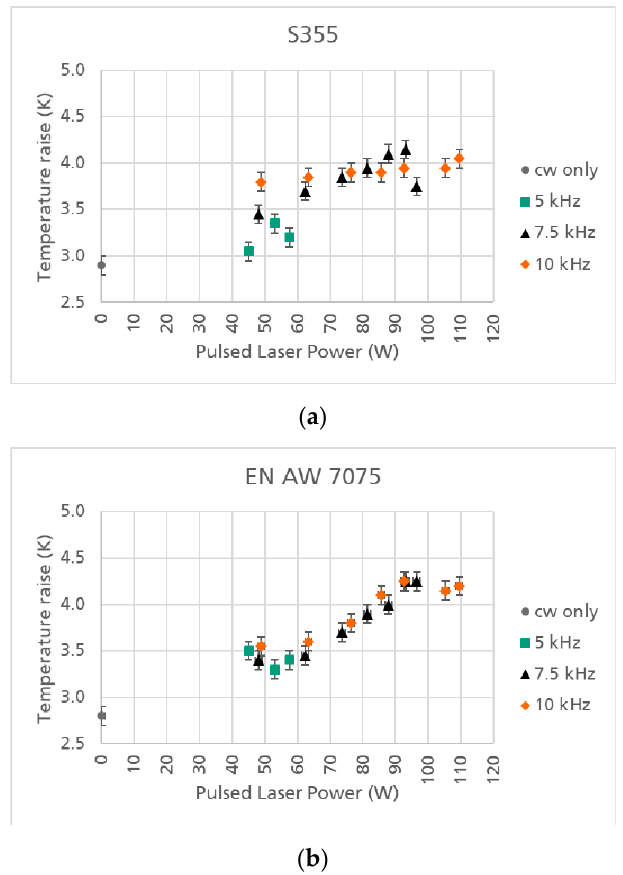
Figure 3. Graphic representation of the temperature raise of the water caused by the S355 ( a ) and EN AW 7075 (AlZn5.5MgCu) ( b ) samples previously processed at 400 W continuous laser power and different pulsed laser frequencies and powers.